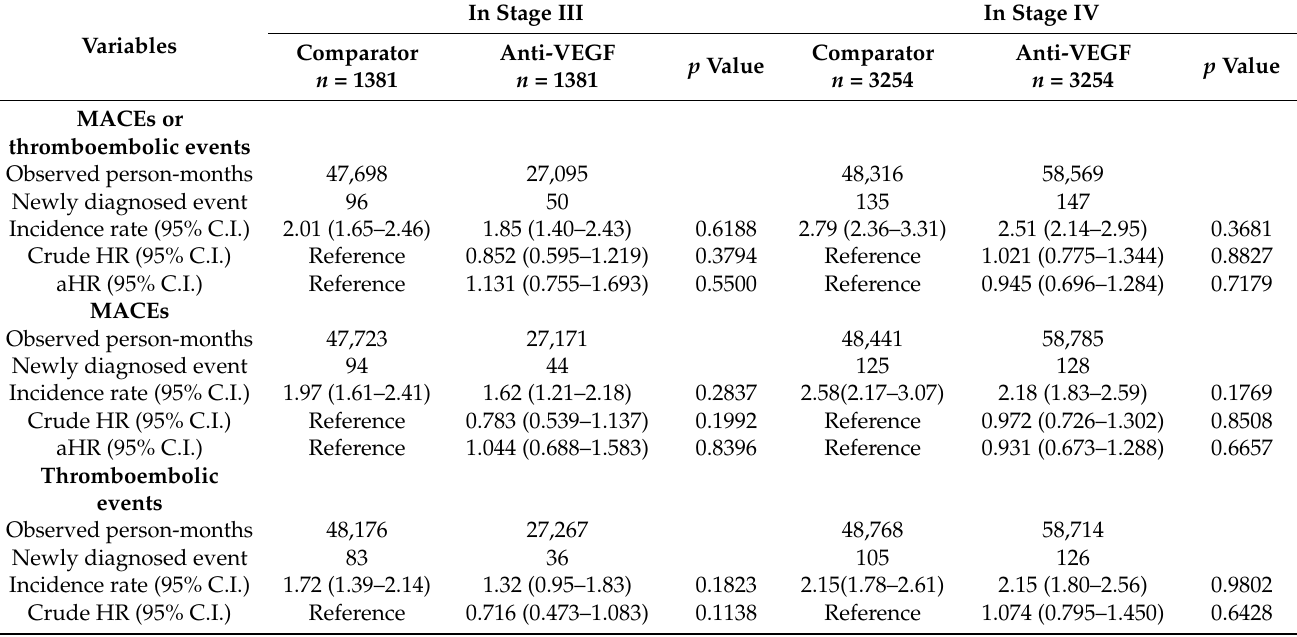
Table 3. The risk of MACEs, thromboembolic events, and all-cause mortality stratified by cancer